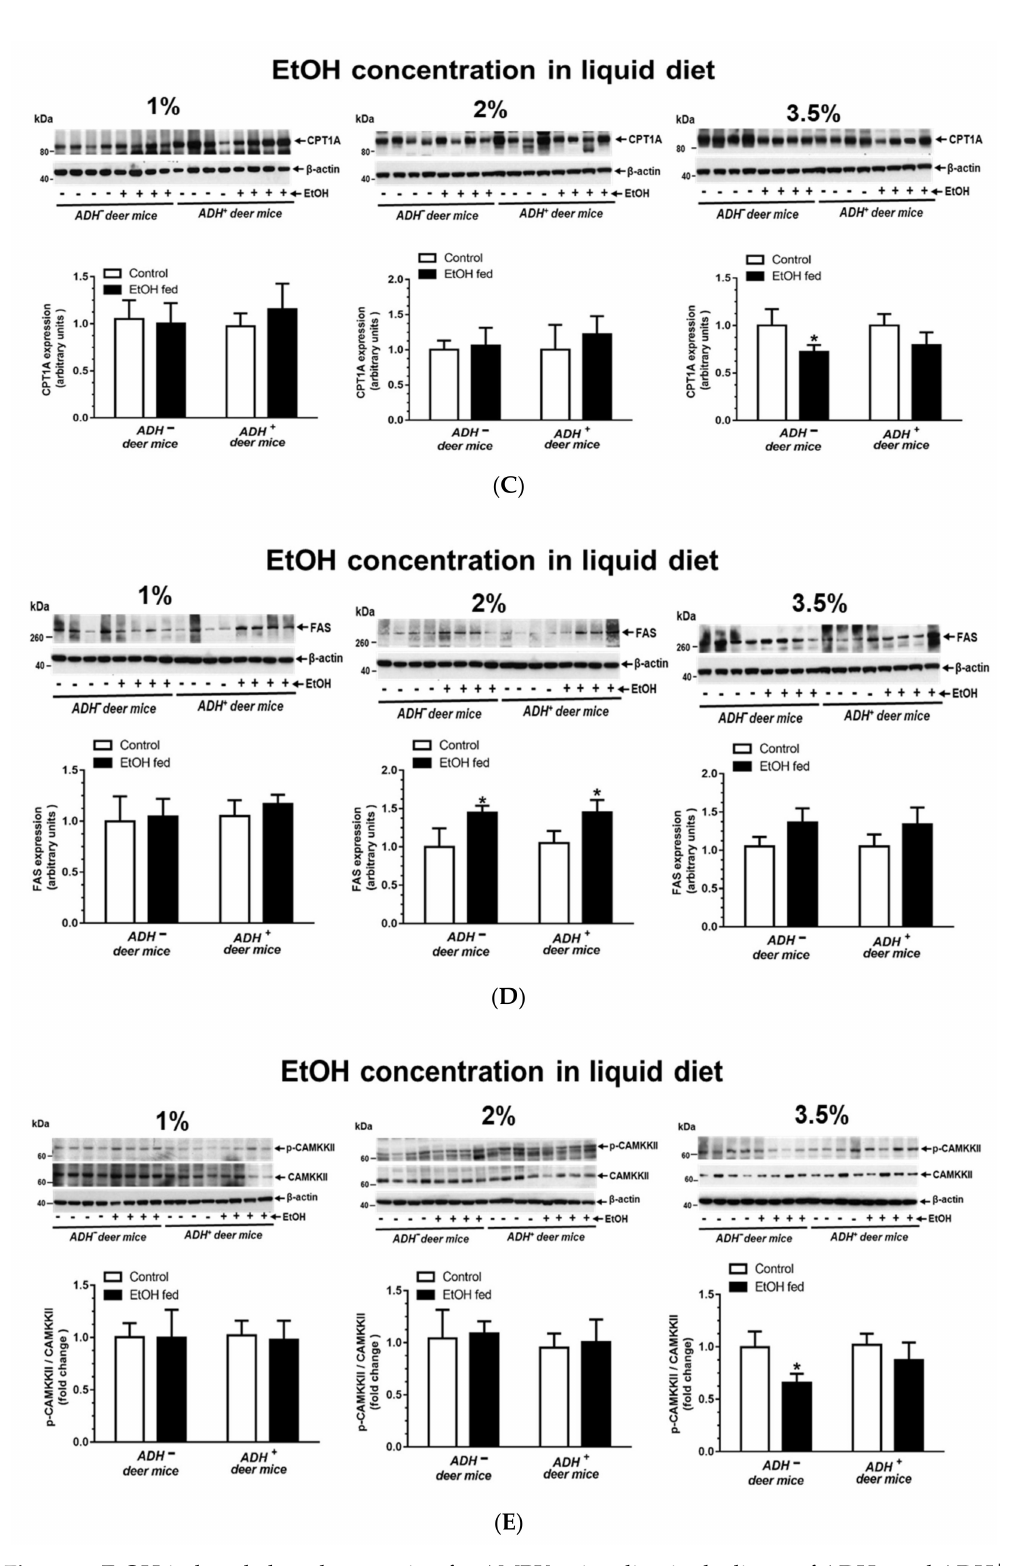
Figure 6. EtOH-induced altered expression for AMPK α signaling in the livers of ADH − and ADH +